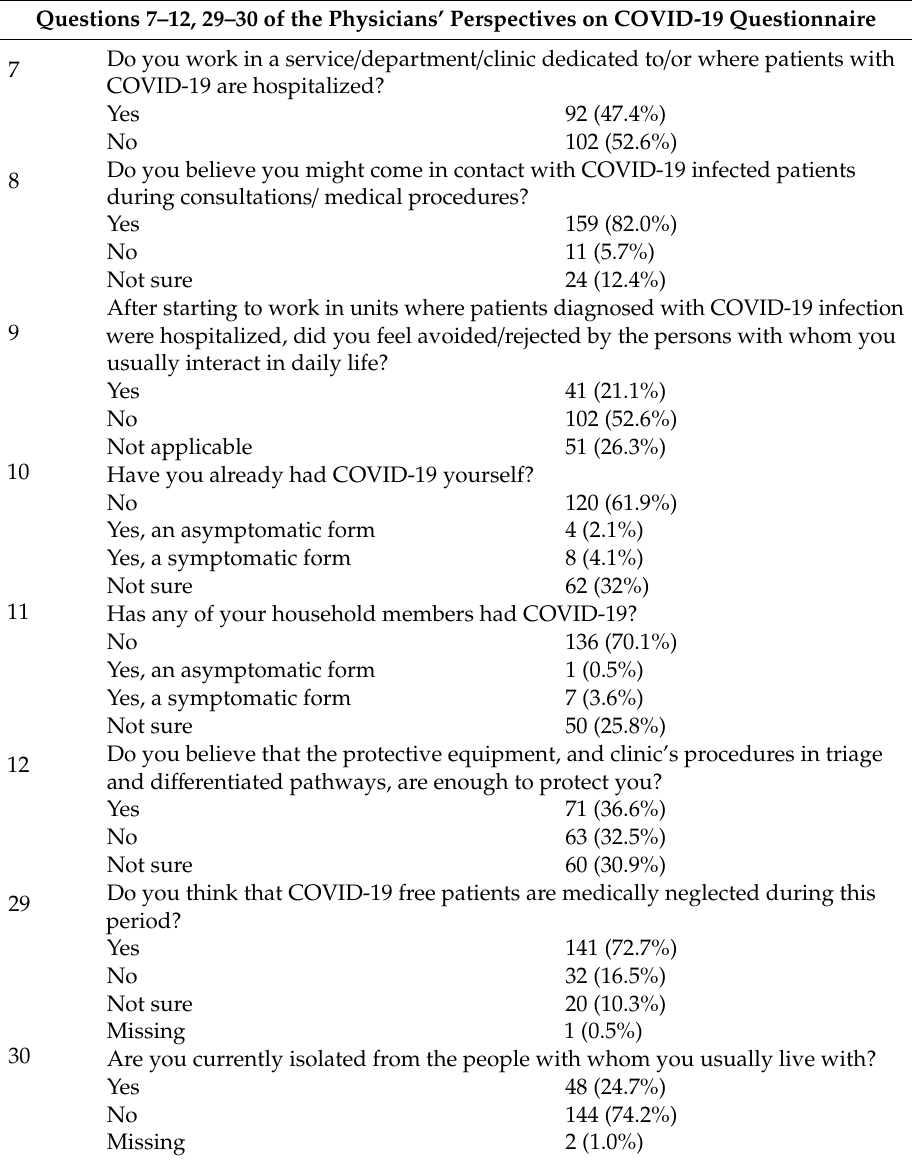
Table 2. Epidemiological and general data regarding